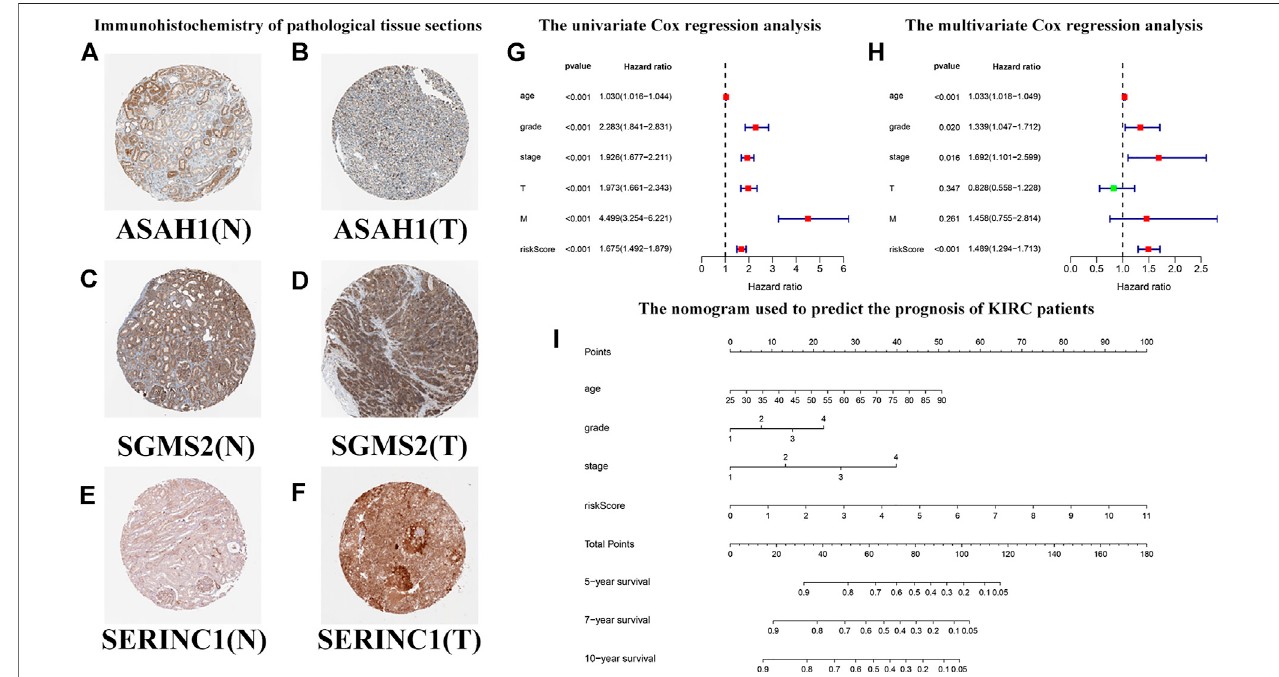
FIGURE11| PredictingtheoutcomesofpatientswithKIRCusinganomogram. (A – F) Immunohistochemistryofpathologicaltissuesections. “ N ” standsfornormal tissue morphology, “ T ” stands for KIRC tumor morphology. (G) Univariate Cox regression analysis of the correlation with risk scores (RSs), clinicopathological parameters (age, grade, stage, T, and M), and overall survival (OS) of patients with KIRC. The forest plot shows that the age, tumor grade, stage, T, M, and RS are correlated with the OS of the patients ( p < 0.05). (H) Multivariate Cox regression analysis of the correlation with RS, clinicopathological parameters, and the OS of patients with KIRC. The forest plot reveals that patient age, grade, stage, and RS are independent risk factors correlated with OS ( p < 0.05). (I) The nomogram incorporates RS, age, grade, and stage, which can be used to predict the outcome of patients with KIRC. The fi rst to fi fth lines represent the points, patient age, tumor grade, tumor stage, and RS. The total score in the sixth row is the sum of the scores for each item from the fi rst to fi fth lines. The 5-, 7-, and 10-year survival rates are predicated based on the total score.